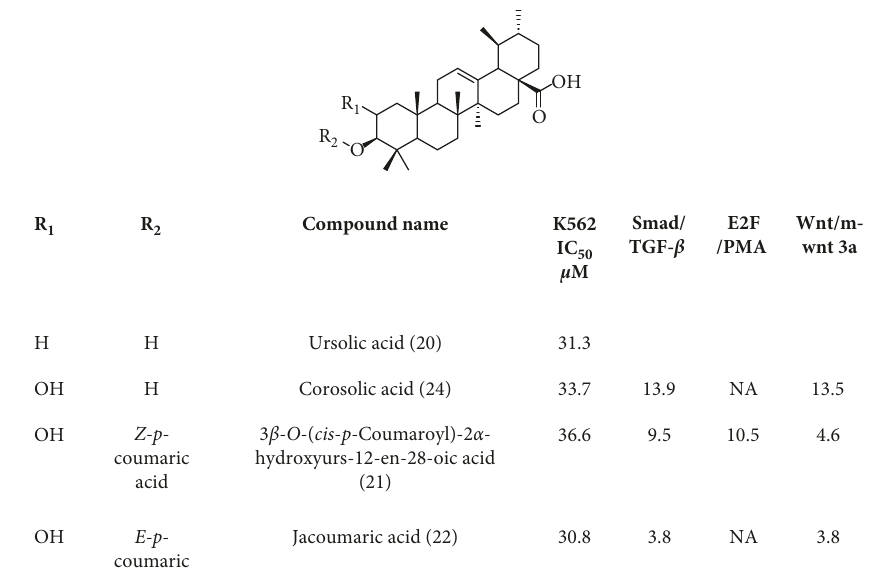
Figure 8: Antileukemic activities of different types of ursane triterpenes isolated from SS leaves.